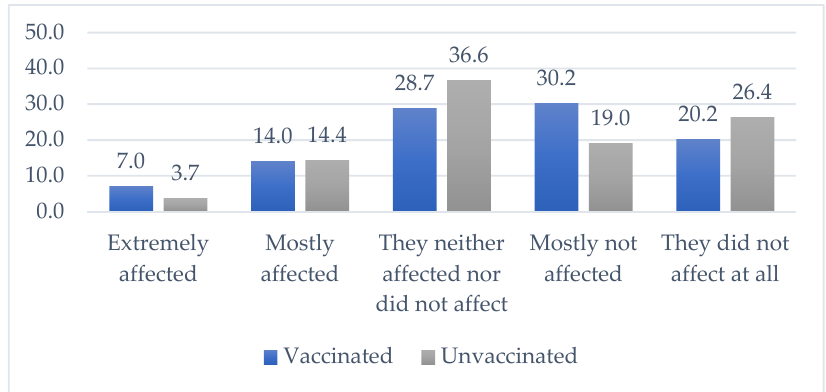
Figure 1. Influence of the media on decision to vaccinate/not vaccinate.